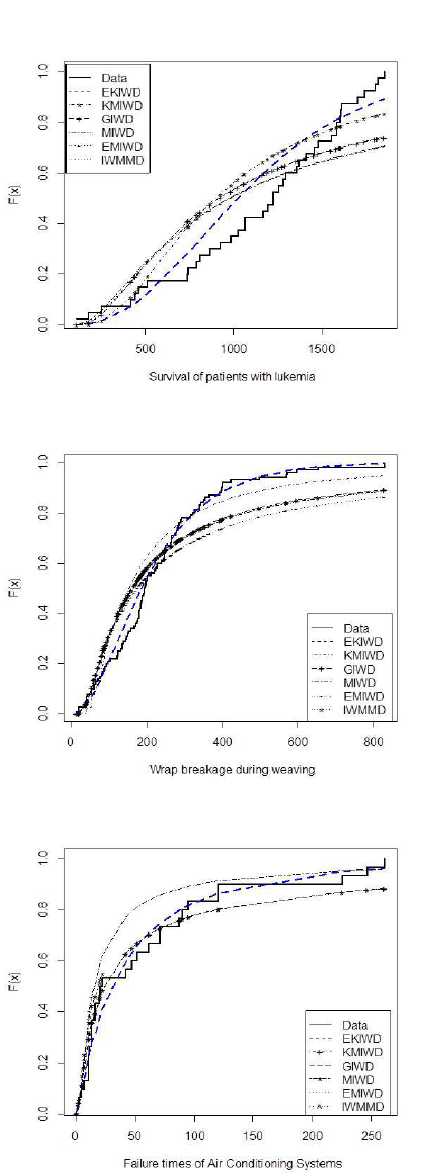
Figure 4 – Cumulative probability plots of EKIWD , KMIWD , EMIWD , MIWD , GIWD and IWMM corresponding to data sets 1, 2 and